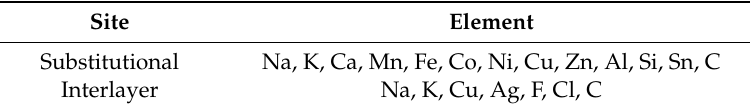
Table 1. Impurity elements considered in the calculation.